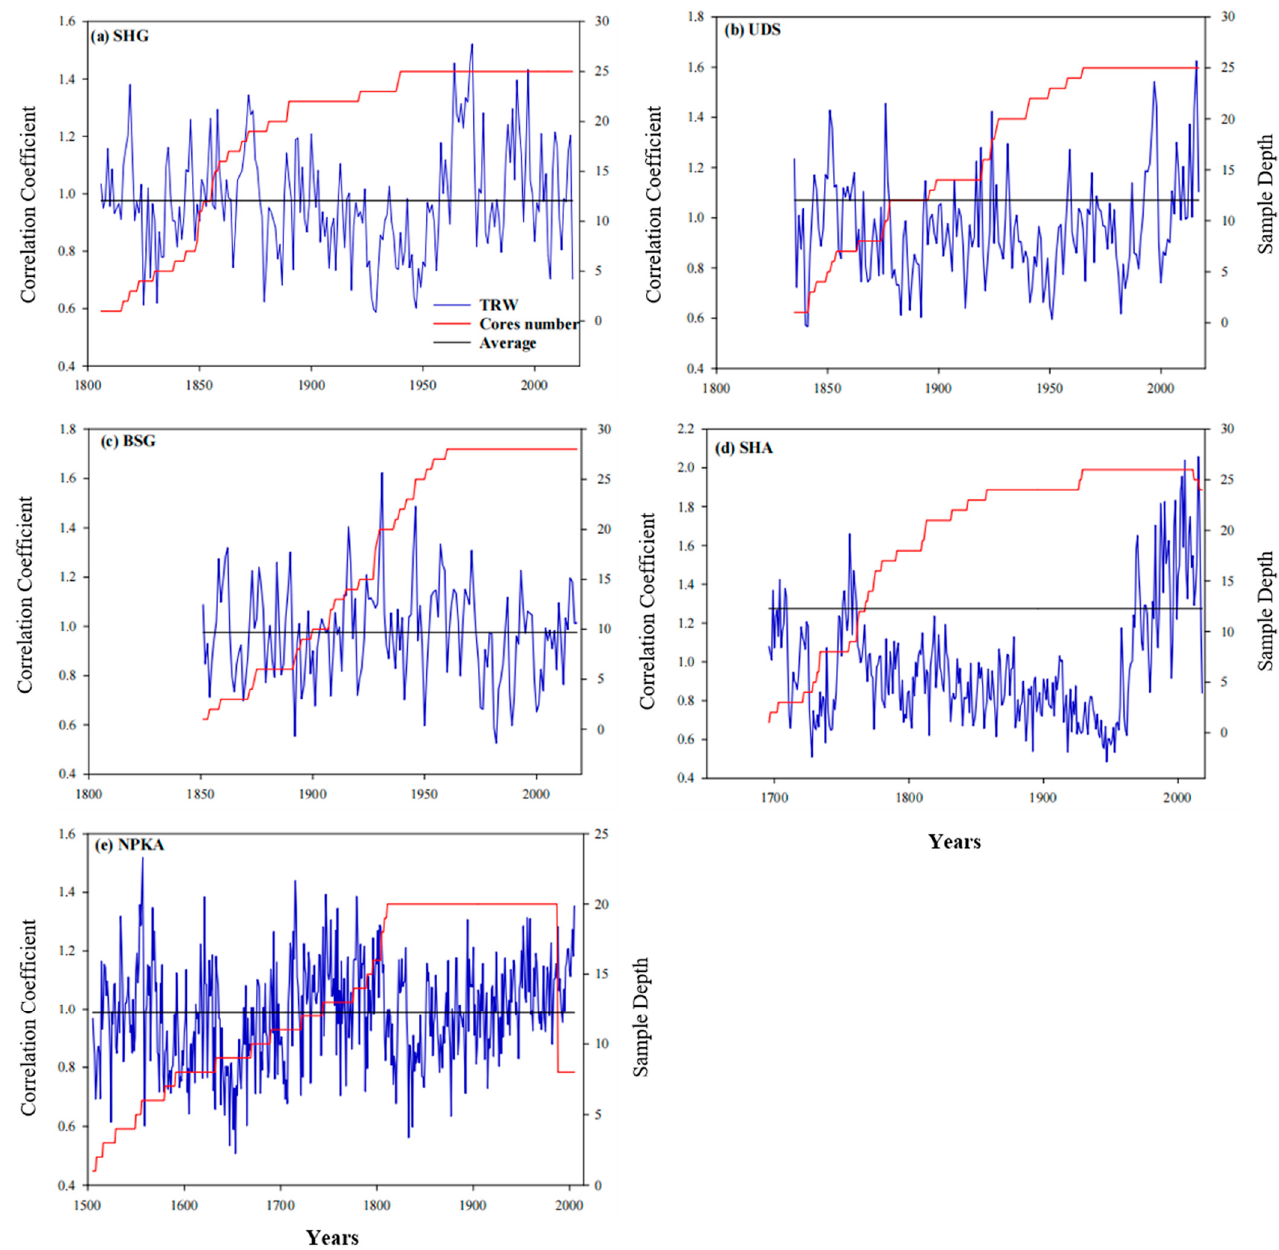
Figure 5. Standard tree ring chronologies of spruce and fir ( a – e ) during 1800–2018 at SHG, UDS, BSG, SHA, and NPKA in the northern area of Pakistan.